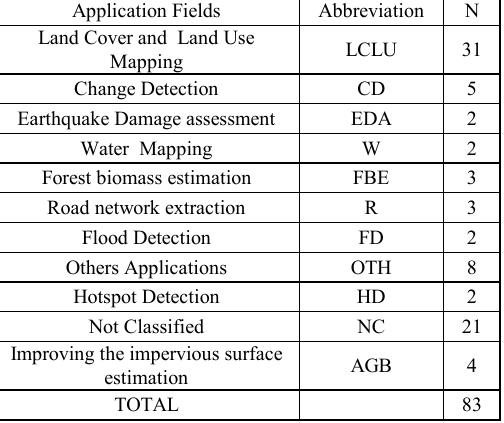
Table 3: Applications fields